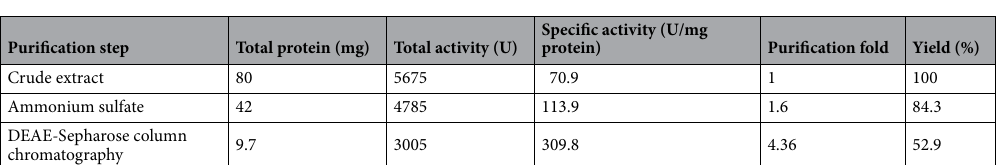
Table 8. Purification of endoglucanase activity. *Specific activity(U/mg) = Total endoglucanase activity (U)/ Total protein(mg). *Purification fold = Specific activity of certain purification step /Specific activity of the